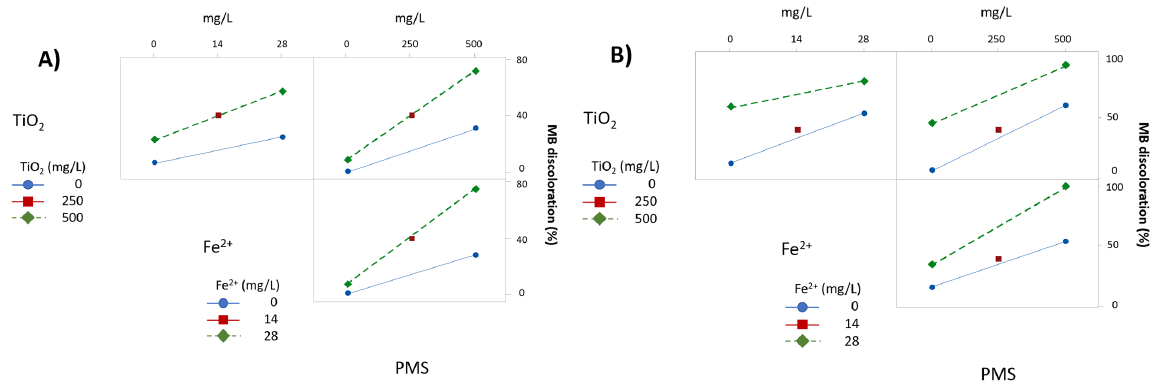
Figure 6. Interaction of variables plot under ( A ) UV-A radiation; ( B ) UV-C radiation, at 10 min of treatment.